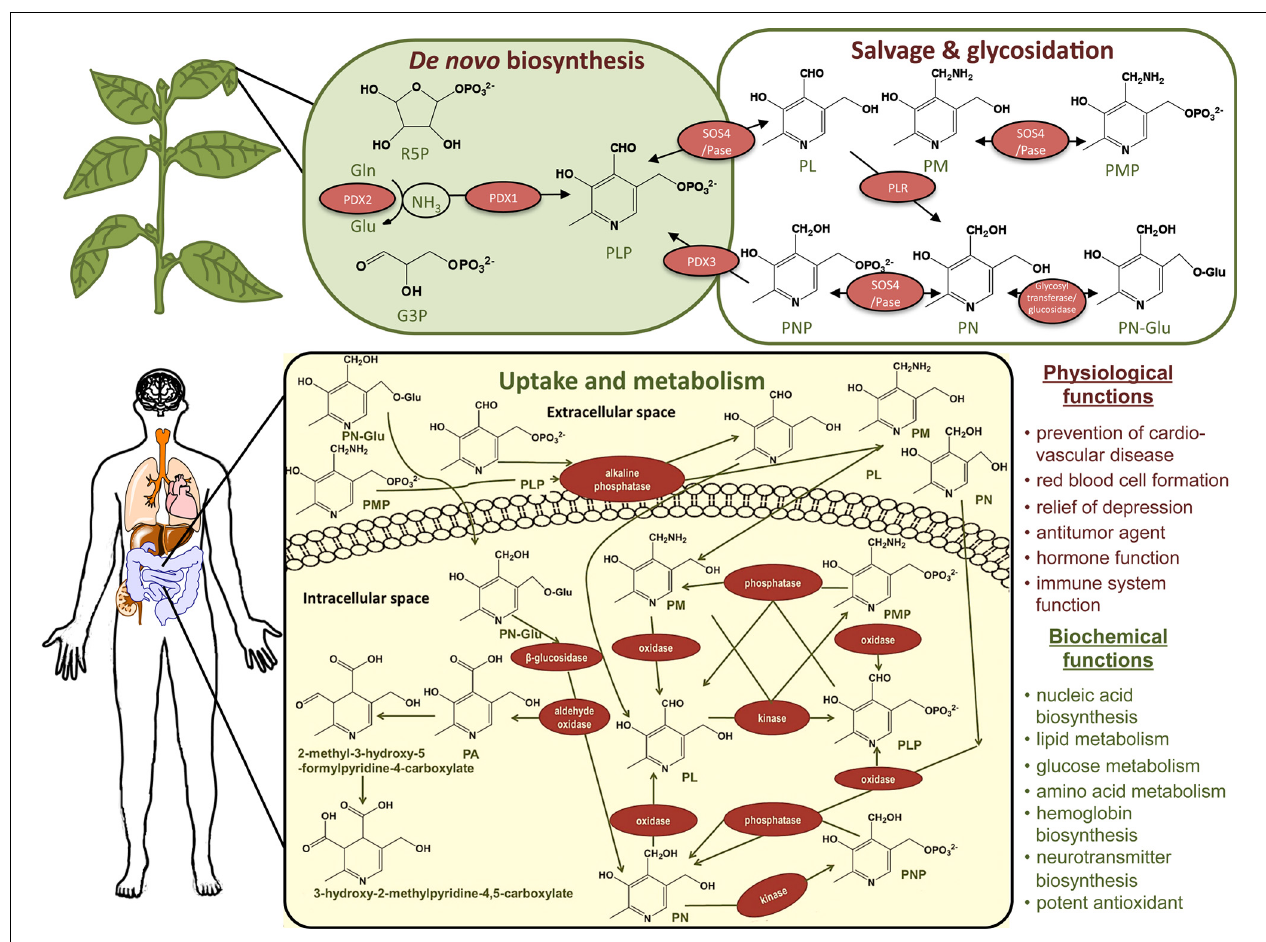
transferase. In the human body, vitamin B6 is taken up in the jejunum (the second part of the small intestine; lower panel) where the free forms PN, PL, and PM can be taken up directly.The phosphorylated vitamers are dephosphorylated prior to uptake by a membrane bound alkaline phosphatase. In both cases uptake is driven by diffusion, which necessitates the phosphorylation of the vitamers immediately after their internalization to keep a low concentration of the non-phosphorylated forms inside the cells. The PN-Glu is taken up in its glycosylated form and processed by a cytosolic β -glucosidase to release PN. Its low bioavailability is not determined by the uptake itself but by the limiting activity of a β -glucosidase.The uptake is followed by further conversion inside the cells (salvage pathway) yielding the active cofactor form PLP involved in numerous biochemical and physiological processes in the human body (right lower panel).The catabolism of the vitamin involves conversion to PA (as well as more oxidized derivatives as depicted).The latter are excreted in the